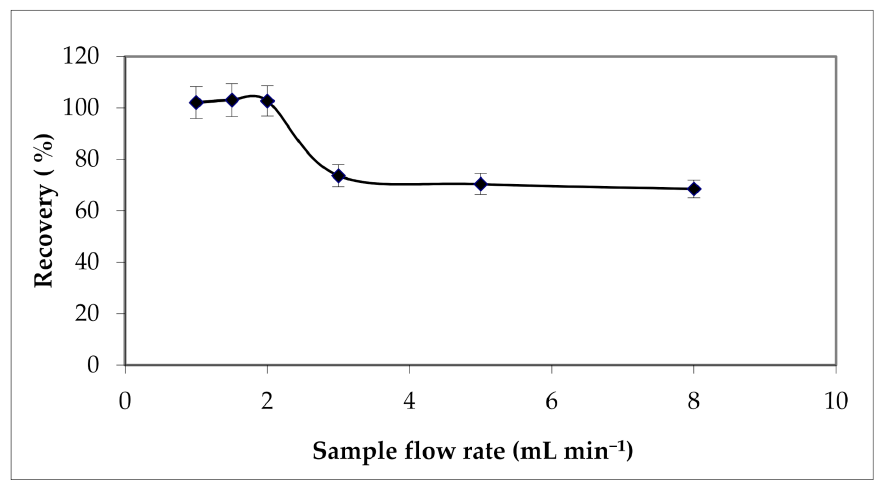
Figure 9. Effect of percolation flow rate on Cu (II) extraction yield. Solvent volume = 12 mL; [HNO 3 ] = 2 mol L − 1 ; the elution flow rate = 2 mL min − 1 ; sample volume = 100